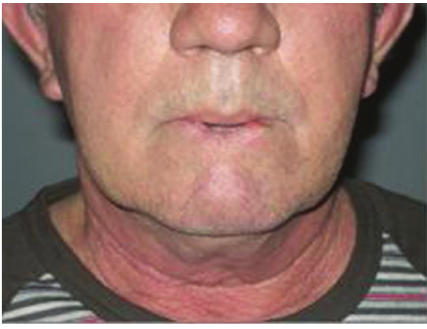
Figure 1: Extended SCC of the lower lip.